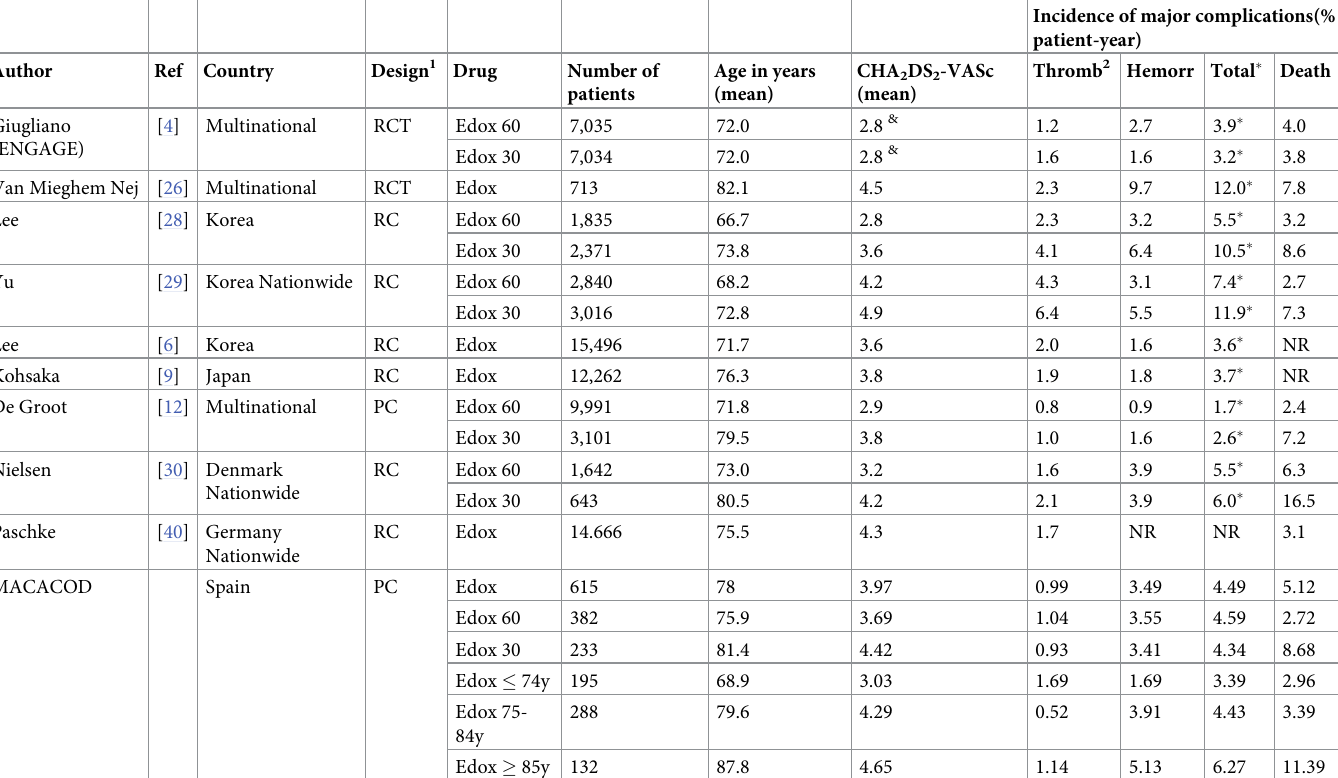
Table 6. Main outcomes with edoxaban from studies in real world or RCTs, in comparison with results from MACACOD, stratified by